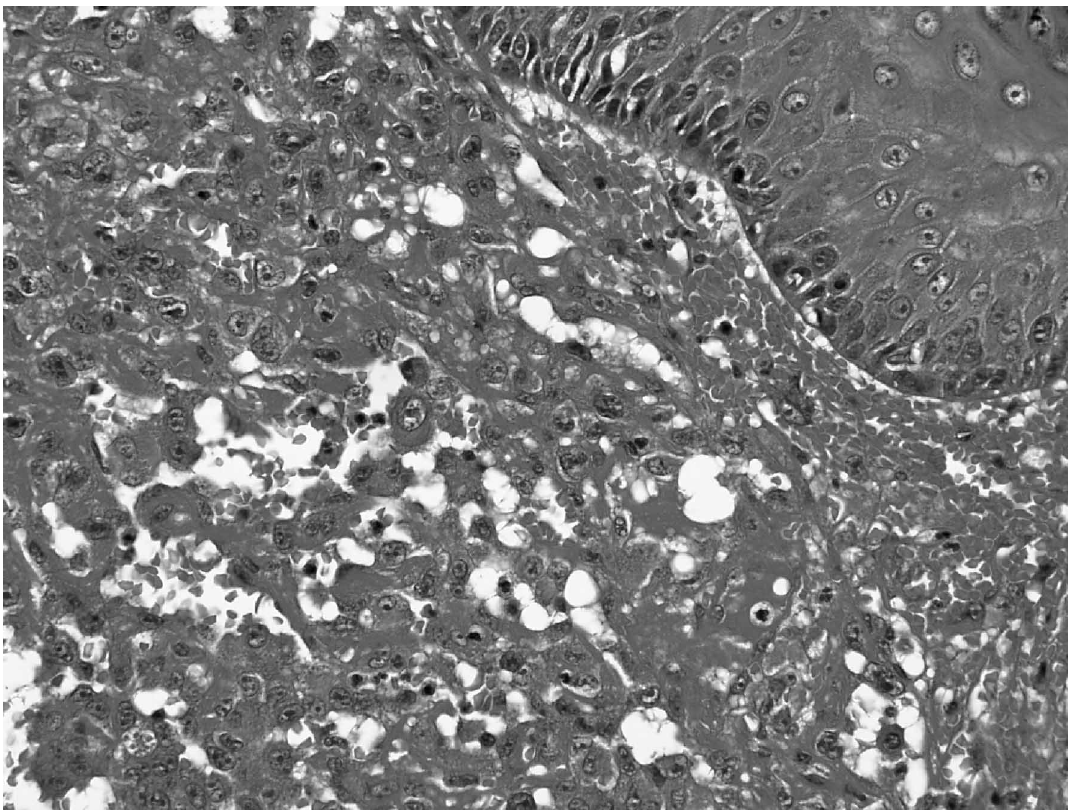
Fig. 2. Skin biopsy (Hematoxillin-Eosin (cid:1) 400). A hemorrhagic malignant proliferation consisting in large cells invades the superficial part of the dermis. Numerous mitoses are